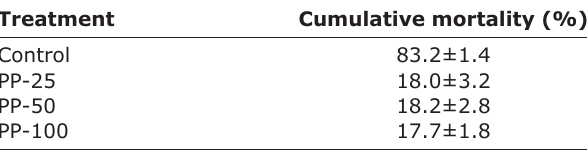
Table-1: Cumulative mortality (%) of fish of the present study.